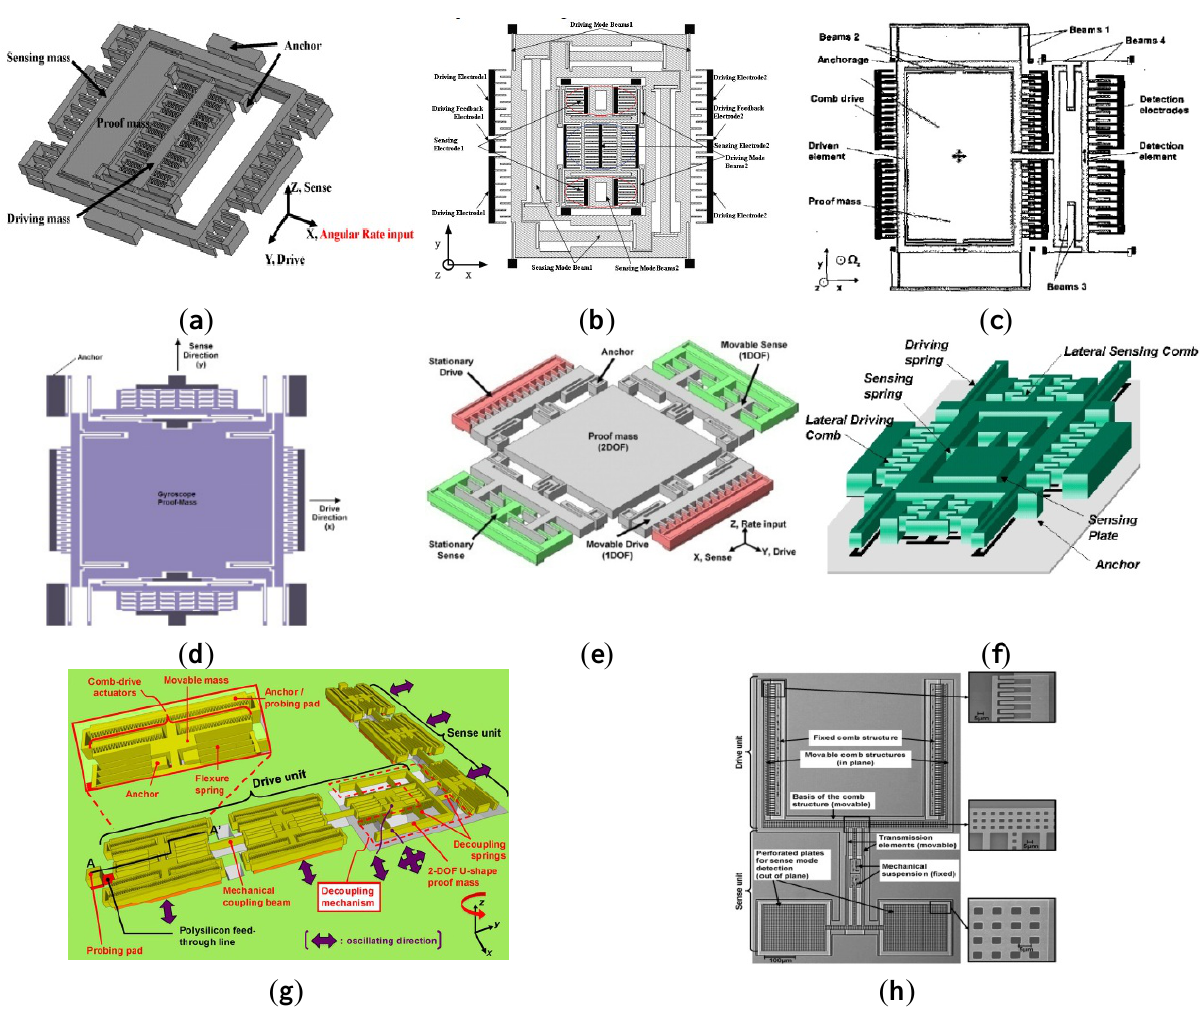
Figure 4. Various decoupled gyroscopes. ( a ) and ( b ) PKU. ( c ) HSG-IMIT. ( d ) UC Irvine. ( e ) Middle East Technical University. ( f ) Korean universities. ( g ) National Taiwan University. ( h ) Saarland